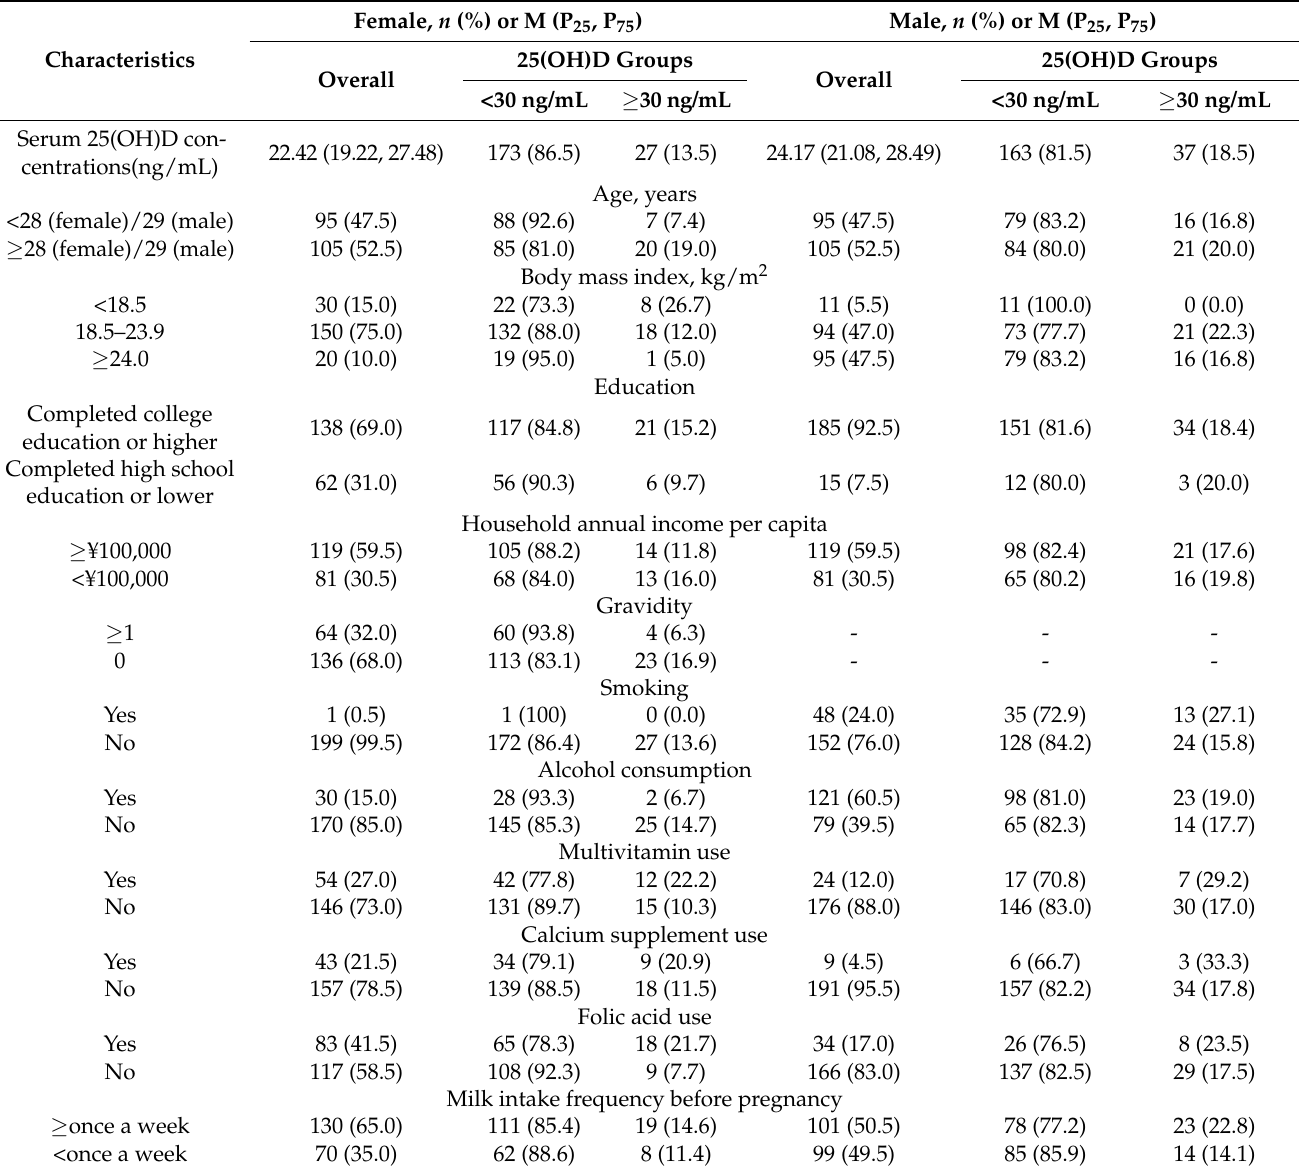
Table 1. Participants’ characteristics by preconception 25(OH)D concentrations in the study ( n =